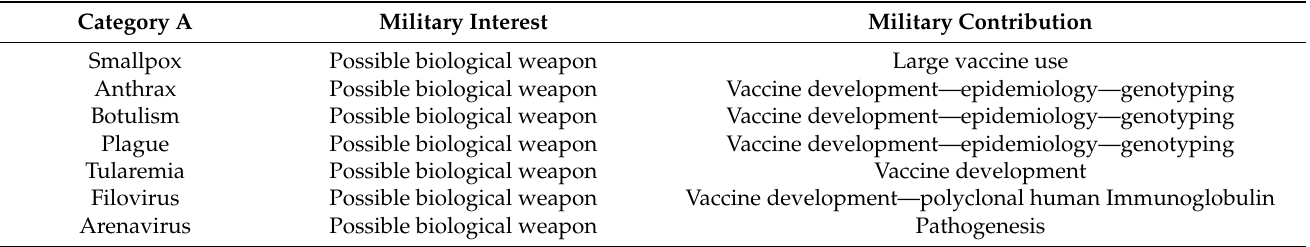
Table 10. Relevance for the military of possible biological weapons and military contribution to their